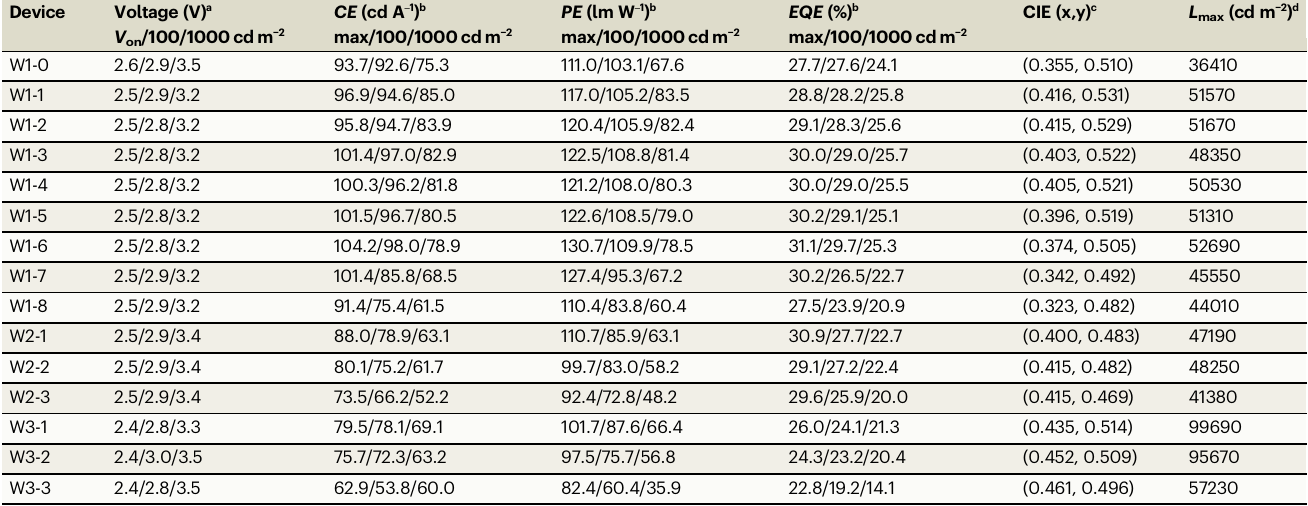
Table 1 | EL performance of two-color all- fl uorescence WOLEDs